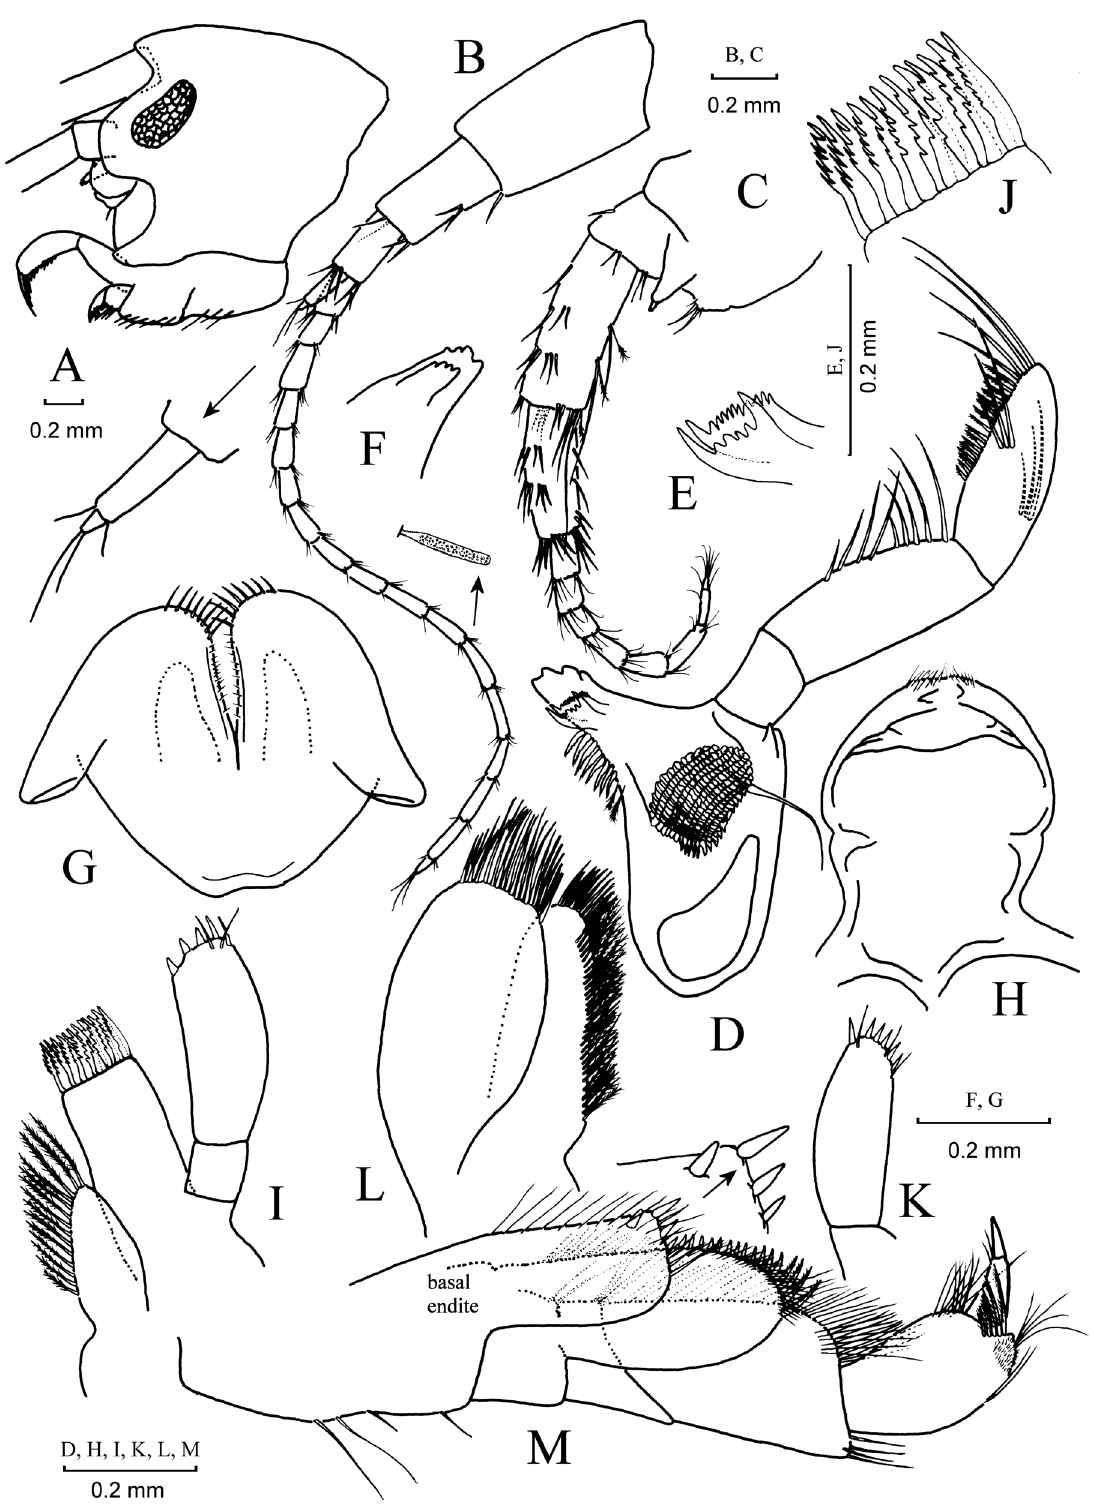
Fig. 3. Gammarus koshovi (Bazikalova, 1946), DAS 16-013, ♀, 8.0 mm. A . Head. B . Antenna I. C . Antenna II. D . Mandible, right. E . Mandible, lacinia mobilis (× 600). F . Mandible, left (part.). G . Lower lip. H . Upper lip. I . Maxilla I, right. J . Maxilla I, outer plate (× 600). K . Palp of maxilla I, left. L . Maxilla II. M .